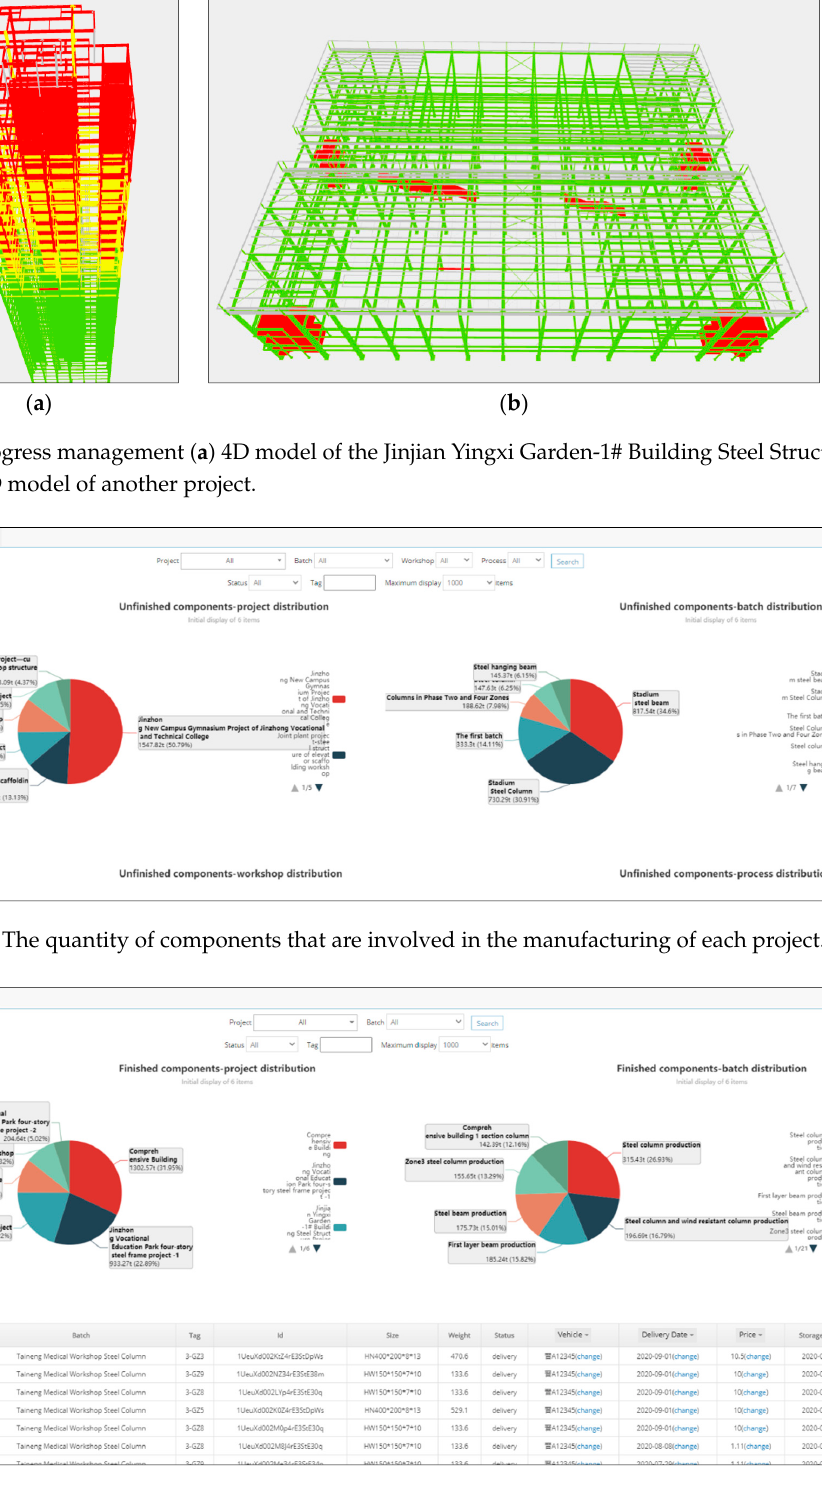
Figure 13. The quantity of components that have been manufactured.